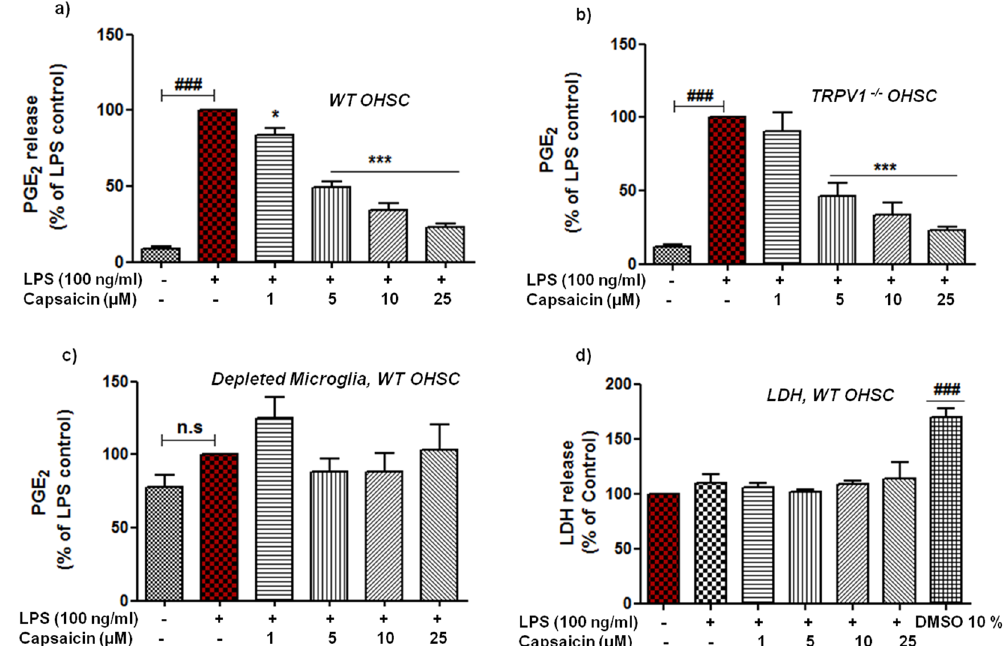
Figure 5. Capsaicin (cap) inhibits the release of PGE 2 in LPS activated OHSCs without affecting the viability of cells. Slices were pre-treated with cap (1–25 µ M) for 30 min followed by incubation with or without LPS (100 ng/ ml) for the next 24 h. Mouse slices were either taken from wild type (wt) animals ( a ) or from TRPV1 − / − animals ( b ). Influence of cap (1–25 µ M) on the release of PGE 2 in microglia-depleted slices ( c ). Cap did not exert any adverse effects on viability of cells in LPS-stimulated slice cultures ( d ). Lactate dehydrogenase (LDH) assay was performed in tissue supernatants to assess the cellular viability after cap (1–25 µ M) treatment in the absence or presence of LPS. Statistical analyses were carried out by using one way ANOVA with post hoc student Newman- Keuls test (Multiple comparisons). Results are expressed as means ± SE of three independent experiments. ### p < 0.001 compared with control cells. * p < 0.05; ** p < 0.01; ** p < 0.001 compared with LPS (100 ng/ml) activated